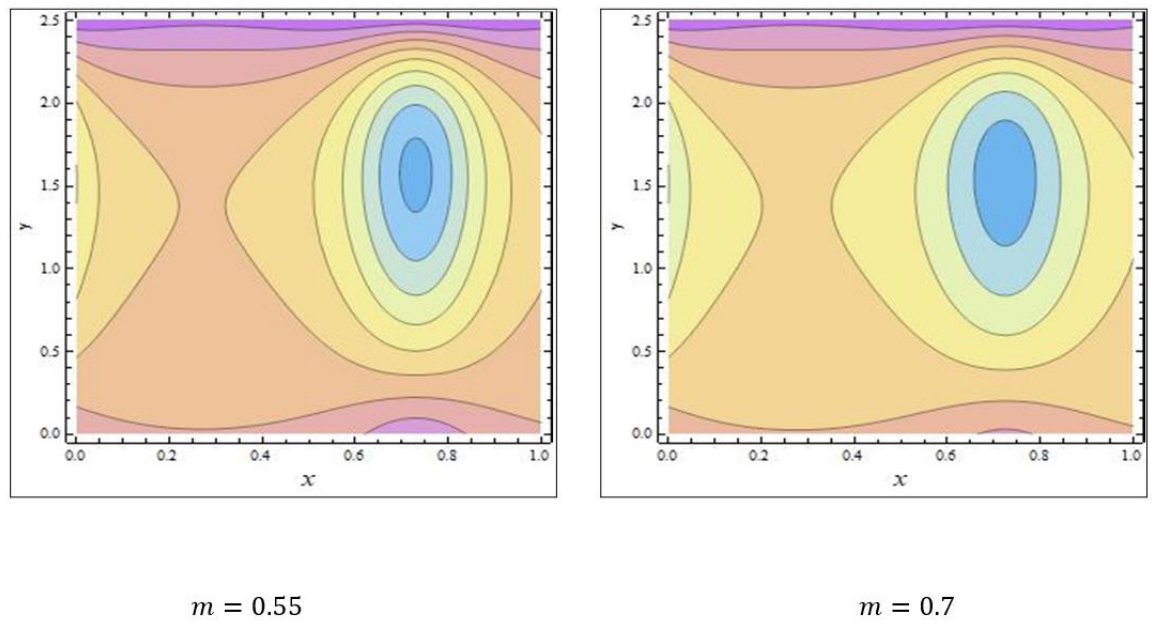
Figure 9. The streamlines of m . The values of the other parameters were N CT = 0.3, N TC = 0.7, G rc = 0.4, G rF = 0.1, G rt = 0.5, N t = 0.7, M = 3.5, φ = π